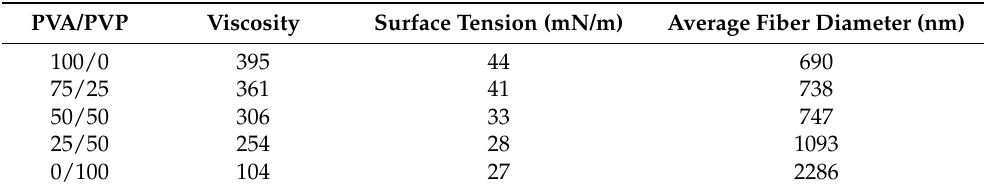
Table 1. Viscosity, surface tension, and average fiber diameter.